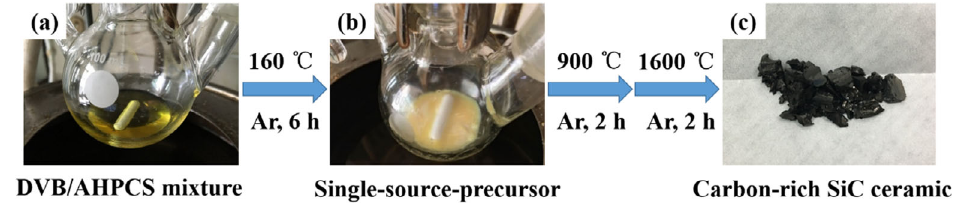
Fig. 1 Photographic illustration of the synthesis